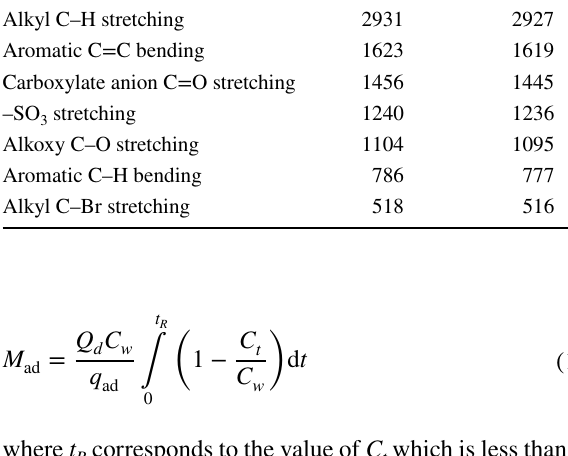
Table 4 Functional group for FTIR analysis Functional